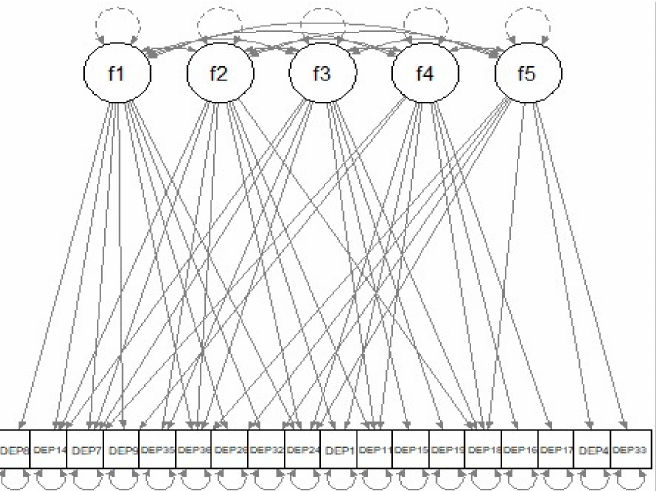
Figure 3. Path diagram of the reduced SEM model with paths set to zero by lasso regularization